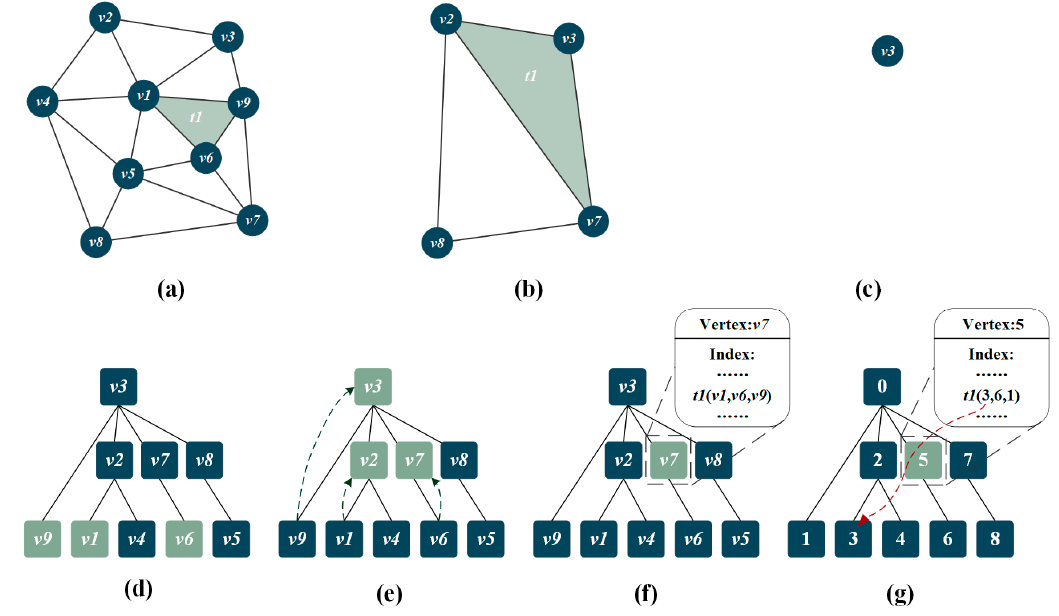
Figure 6. Extraction of the related triangle set: ( a – c ) The change of triangle t 1 in the process of multi-level vertex clus- tering; green nodes indicate the location where t 1 is stored, respectively under ( d ) initial conditions ( e ) after multi-level vertex clustering ( f ) after eliminating the redundancy; ( g ) during recoding, the index changes with the encoding of the vertex